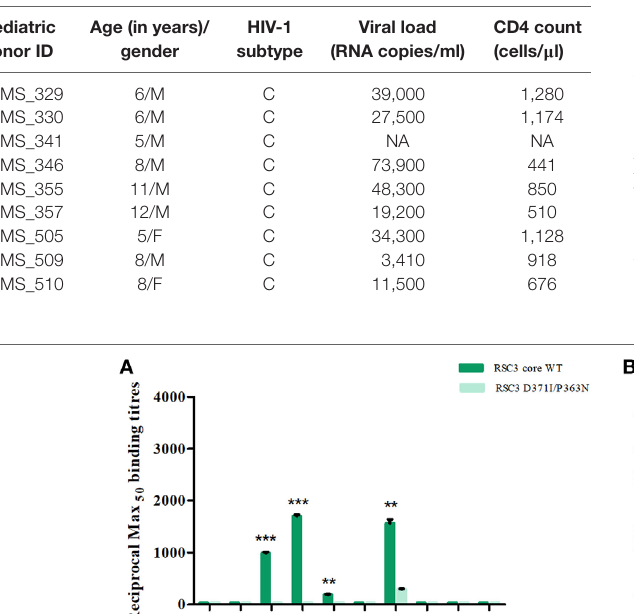
TaBle 1 | Clinical and demographic profile of 9 chronically HIV-1 infected children at the time of enrollment in study.